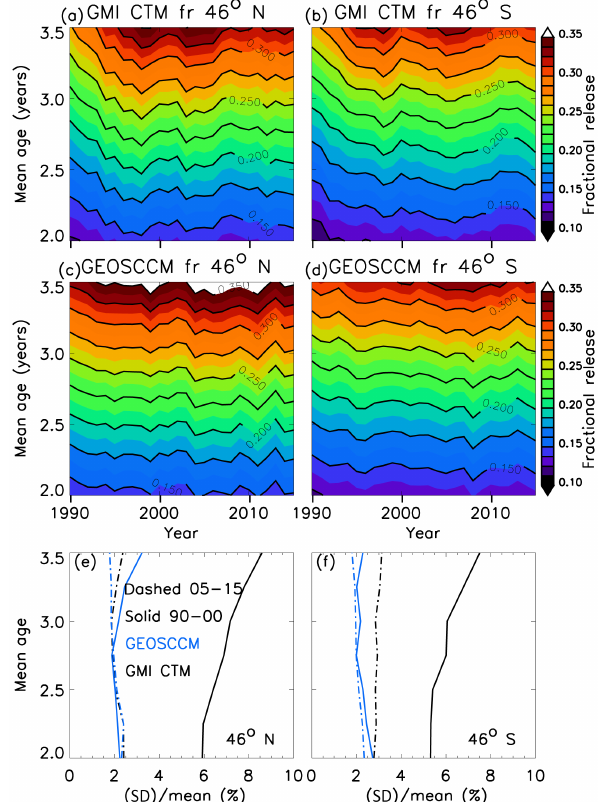
Figure 2. Contours of the evolution of N 2 O fractional release sim- ulated by GMI CTM for 1990–2015 as a function of mean age at (a) 46 ◦ N and (b) 46 ◦ S. Same for the GEOSCCM at (c) 46 ◦ N and (d) 46 ◦ S. The ratio of the standard deviation of the N 2 O fractional release to the mean value from GMI CTM (black) and from GEOSCCM (blue) averaged from 1990 to 2000 (solid) and from 2005 to 2015 at (e) 46 ◦ N and (f) 46 ◦